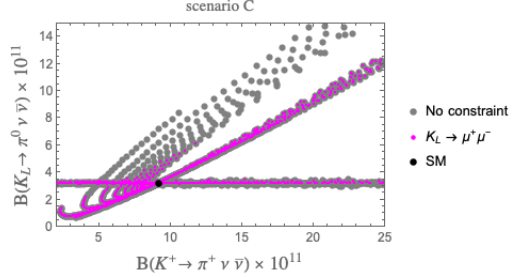
Figure 17 . Scenario C. Correlation between B ( K L ! (cid:25) 0 (cid:23) (cid:22) (cid:23) ) and B ( K + ! (cid:25) + (cid:23) (cid:22) (cid:23) ). The black dot represents the central value of the SM prediction.